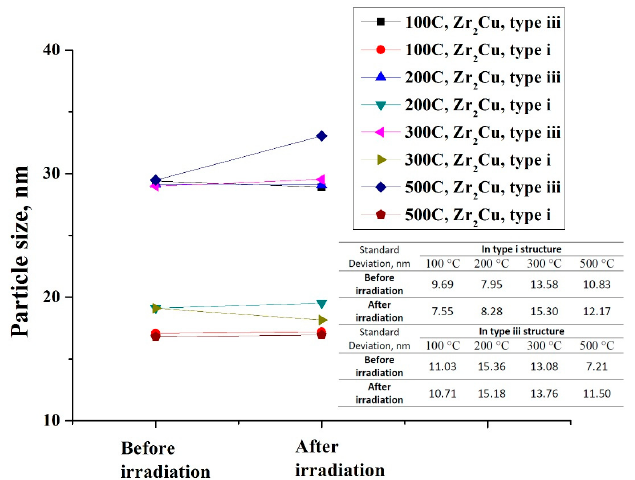
Figure 7. The size of Zr 2 Cu precipitates in type i and iii structures before and after irradiation at 100 ◦ C, 200 ◦ C, 300 ◦ C, and 500 ◦ C, respectively. The standard deviation of the measurements is inserted in the right corner.